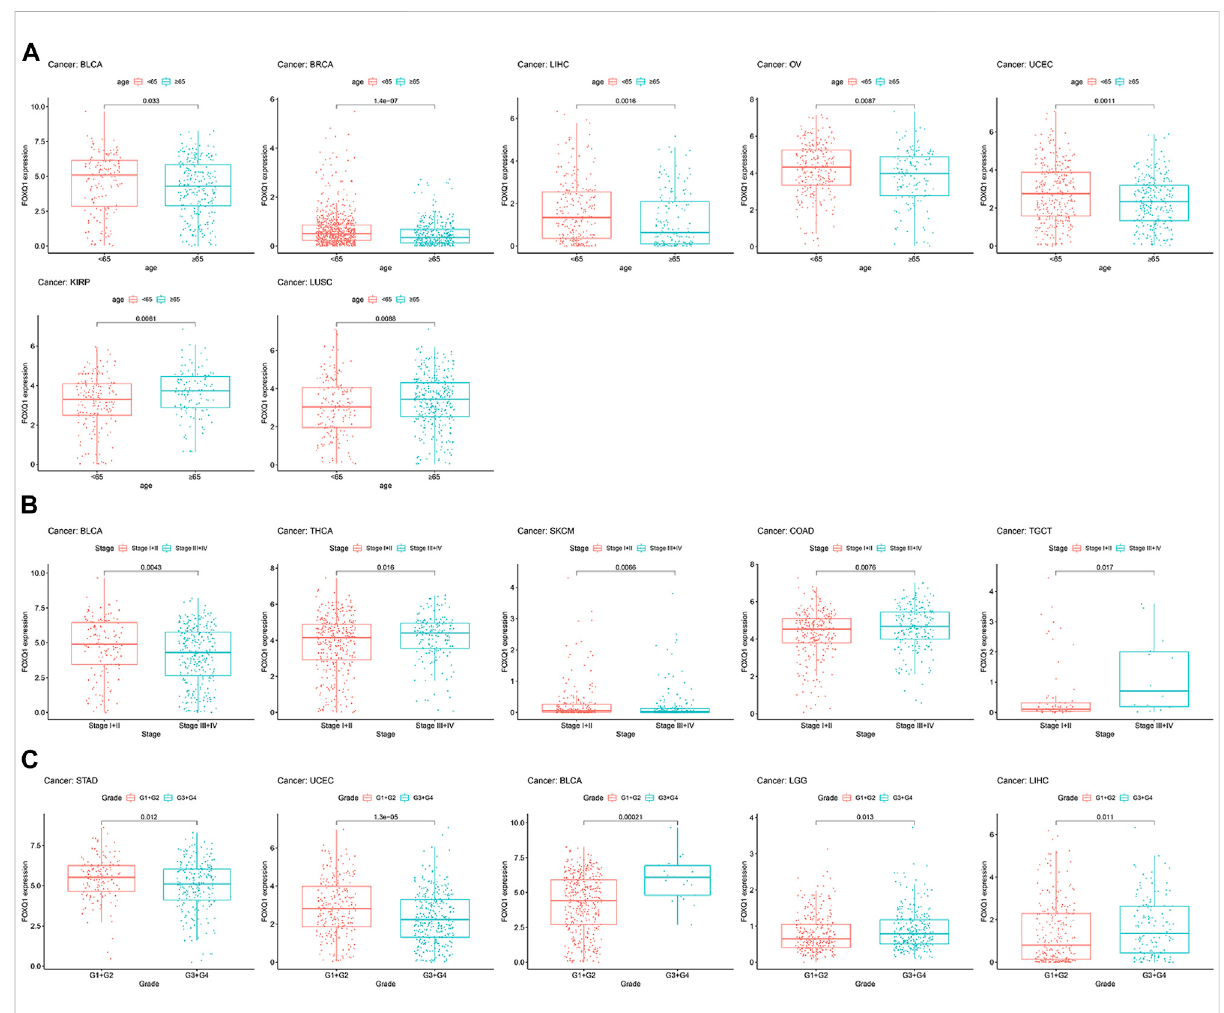
FIGURE 6 Correlation between forkhead box Q1 (FOXQ1) expression and clinical pathological parameters in pan-cancer. (A) association of FOXQ1 expression with age. The red color represents < 65 years, and the blue color represents ≥ 65 years. (B) association of FOXQ1 expression with stage. The red color represents the I + II stage, and the blue color represents the III + IV stage. (C) association of FOXQ1 expression with grade. The red color represents G1 + G2, and the blue color represents G3 +